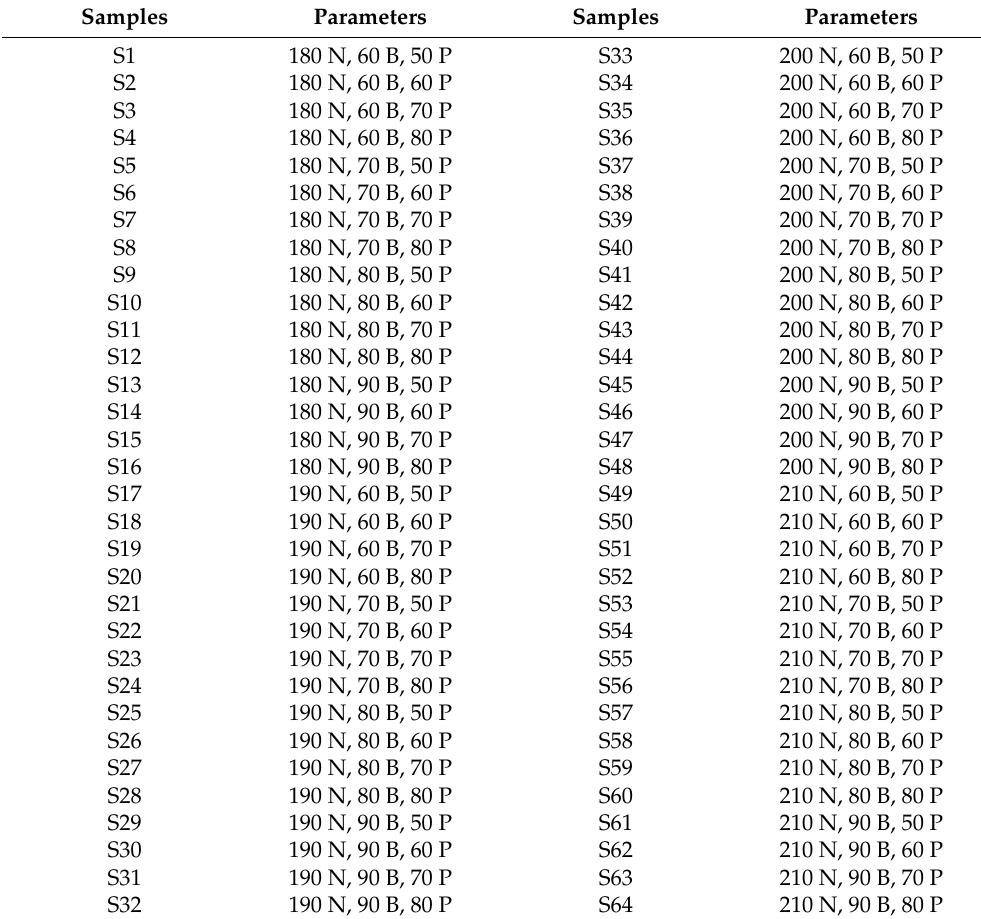
Table 2. Combination of processing parameters (N = nozzle temperature; B = print bed temperature; P = print speed).